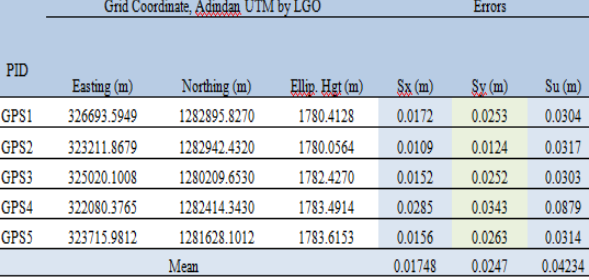
Table 3. LGO-derived GPS coordinates of the checkpoints from local GPS